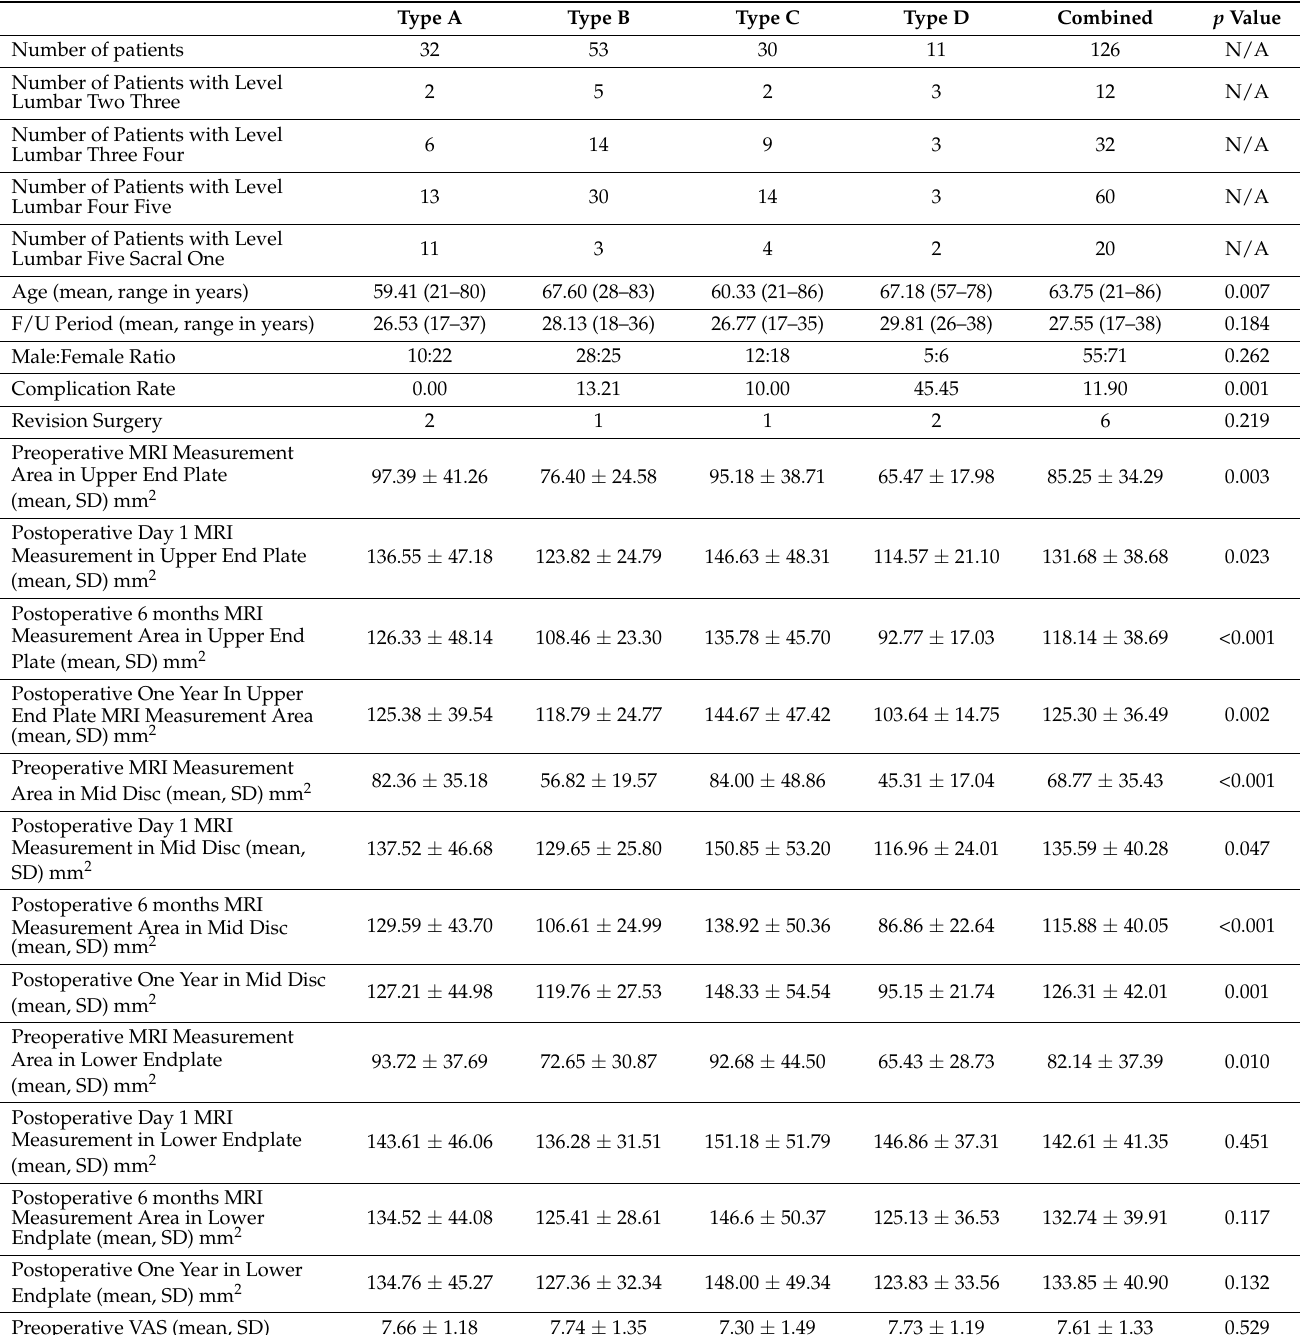
Table 2. Baseline demographics and characteristics of the four types of remodeling after lumbar endoscopic unilateral laminotomy with bilateral decompression (LE-ULBD). The chi-square test for categorical variable and ANOVA test for continuous variables were used to compare the groups. Tukey’s multiple comparison test was used for the post-hoc test in continuous